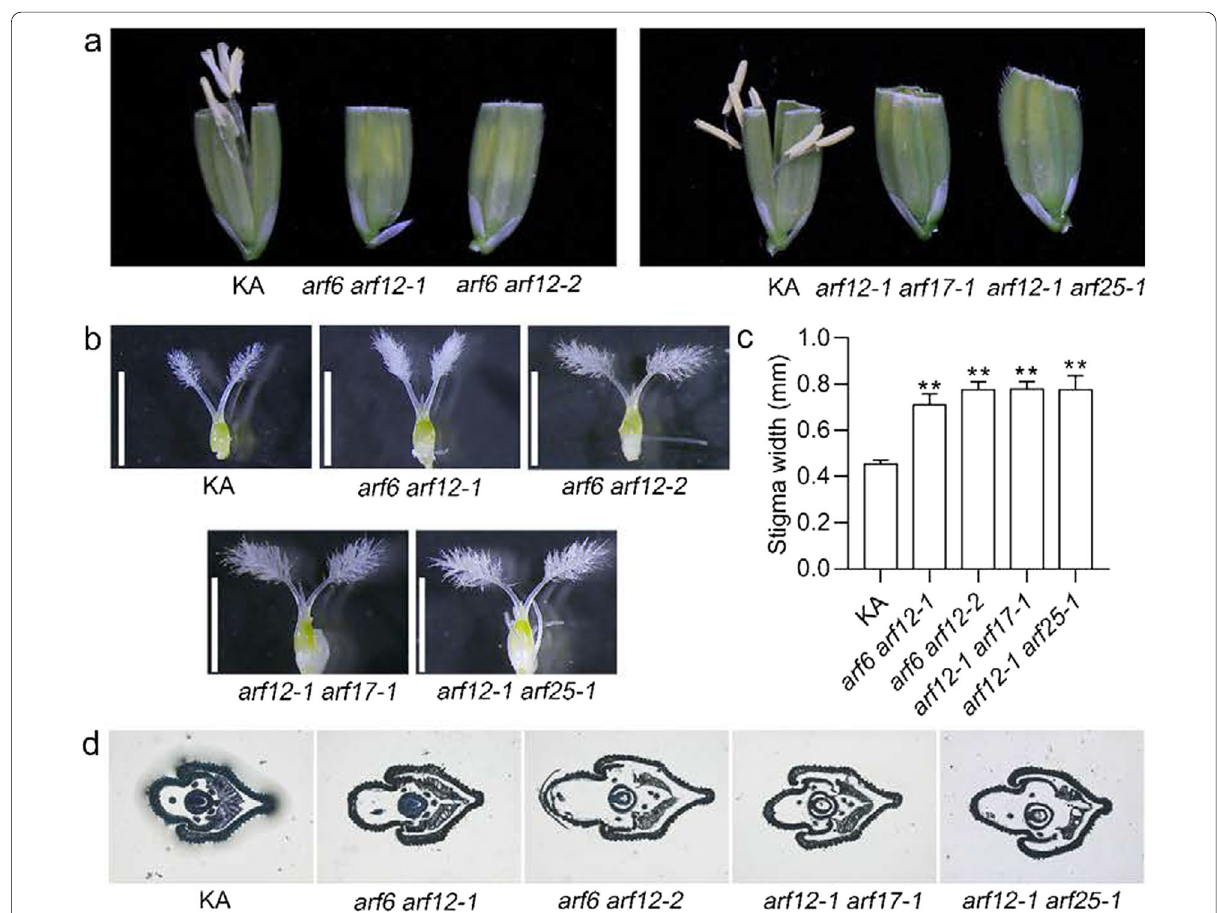
Fig. 7 Phenotypic analysis of the floral organs in ARF double mutants. a The phenotype of the filament elongation in the indicated lines. b Phenotype of the pistils. Bars, 2 mm. c Comparison of the stigma width. Error bars indicate the standard deviation (SD)